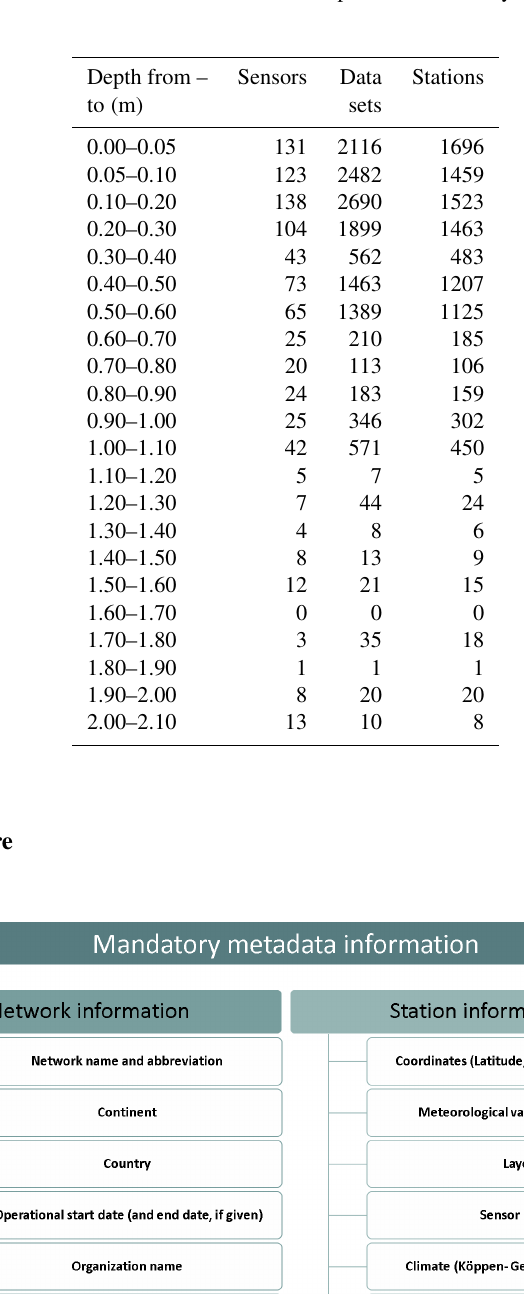
Table C1. Overview of data availability per depth layers showing the total number of individual sensor brands, data sets, and stations integrated in the ISMN database. The calculations have been made with respect to horizontally and vertically placed sensors for each depth layer.